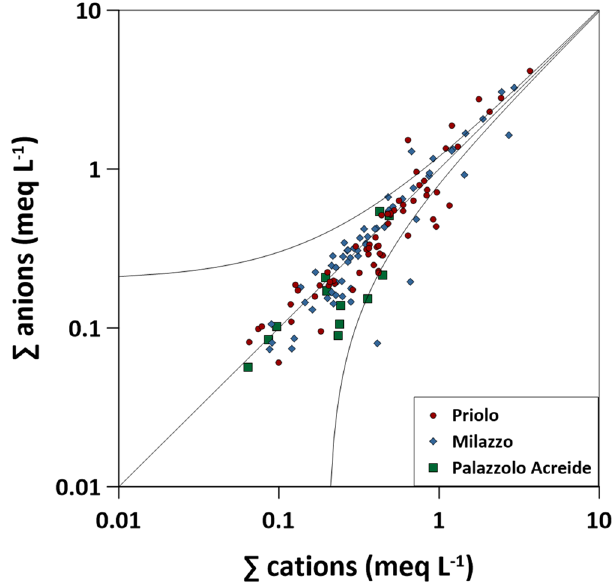
Figure 3. Sum of anions vs. sum of cations binary diagram. ∑ anions = Cl − + NO 3 − + SO 42 − + HCO 3 − + F − and ∑ cations = Ca 2+ + Na + + Mg 2+ + K + . The black line (1:1) represents the charge balance between anions and cations. The area between the two black curves represents the acceptable balance error following the standard analytical methods (APHA, AWWA, WEF, 2005 [51]).